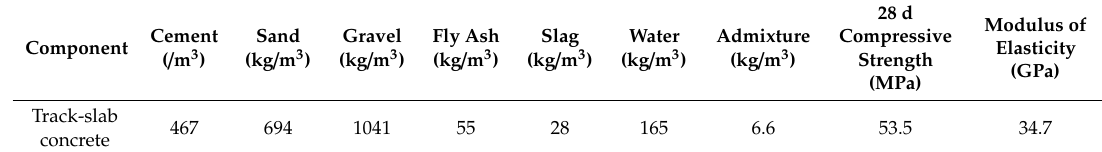
Table 1. Mixing proportion and performance indicators of the track-slab concrete specimen.